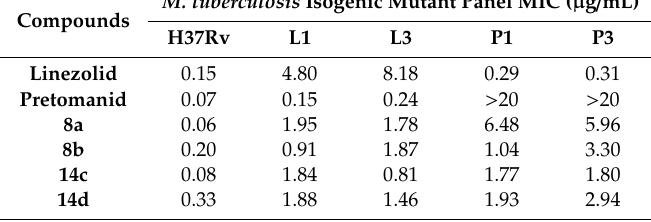
Table 1. Minimum inhibitory concentrations of selected conjugate molecules against isogenic resistant mutant strains of M. tuberculosis .